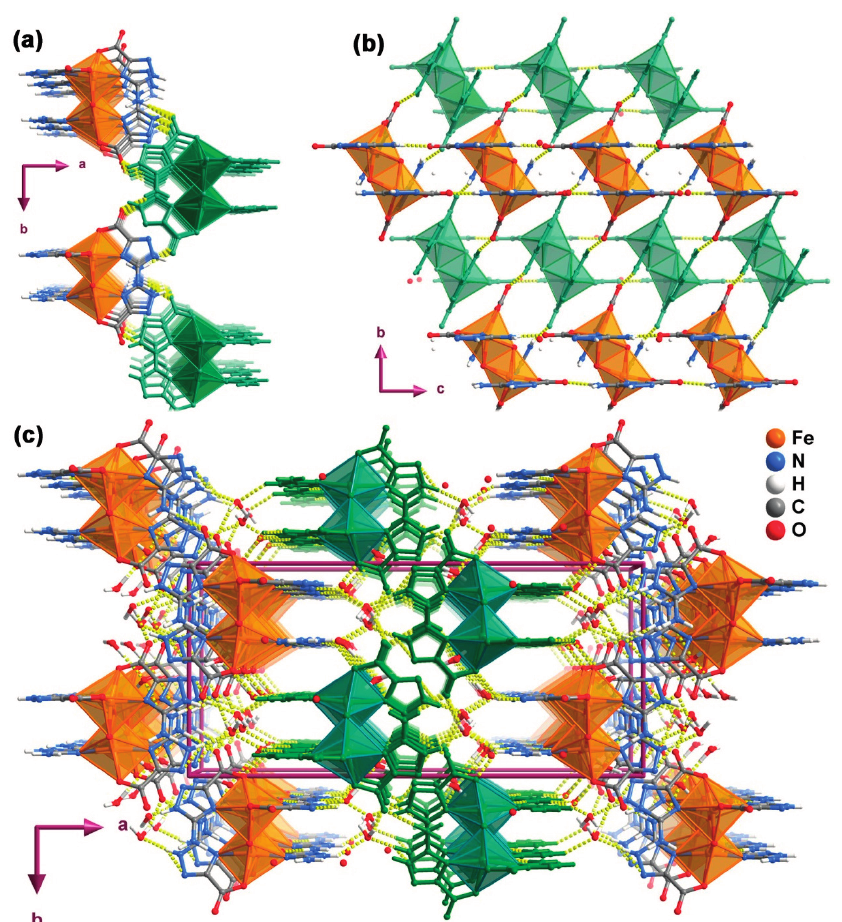
Figure 6. Ball-and-stick representation of the 2D hydrogen-bonded layer present in compound 3 viewed along the ( a ) [001] and ( b ) [100] directions of the unit cell (1D supramolecular chains represented in alternate colors); ( c ) Perspective view of the 3D supramolecular framework (layers alternate between colors) present in the crystal structure of 3 . Dashed yellow lines represent the hydrogen bonds. Geometric details on these supramolecular interactions are summarized in Table